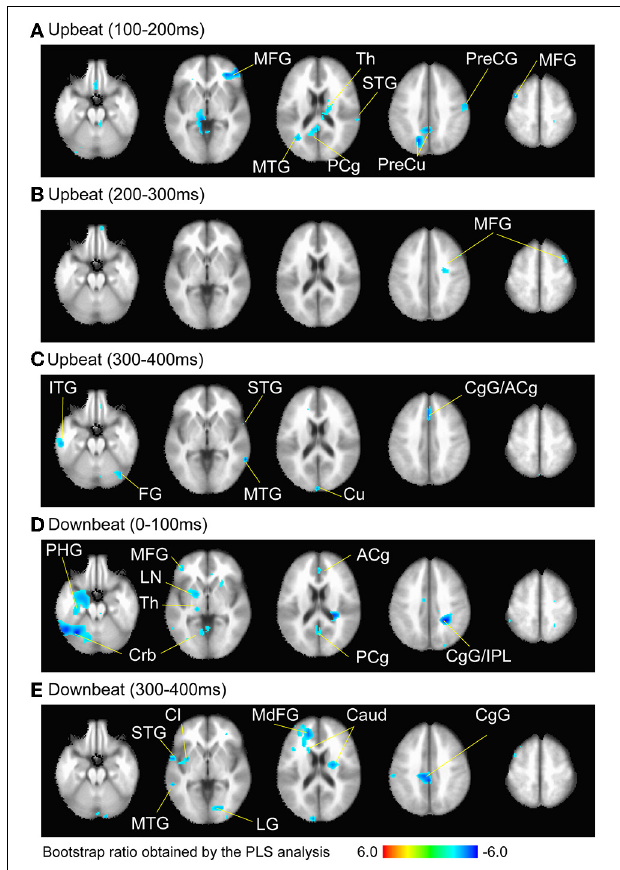
FIGURE 6 | Brain areas contributing to the contrast between the three metric conditions at the time windows (A) 100–200ms, (B) 200–300ms, and (C) 300–400ms after the upbeat onset, and (D) 0–100ms and (E) 300–400ms after the downbeat onset. The color indicates the bootstrap ratio of a given voxel as the spatial component of the PLS-identified brain-LV. Only the areas where absolute value of the bootstrap score was larger than 3.0, where the contrast was found significant, are shown. Note that thresholding resulted in only cold colored areas correlating with the negative sign of the design-LV values in the contrast pattern indicated in the Figure 5 . The anatomical labels are taken from the local maxima and minima of these voxels in Tables 1 , 2 , respectively. Abbreviation: ACg, anterior cingulate; Caud, caudate;